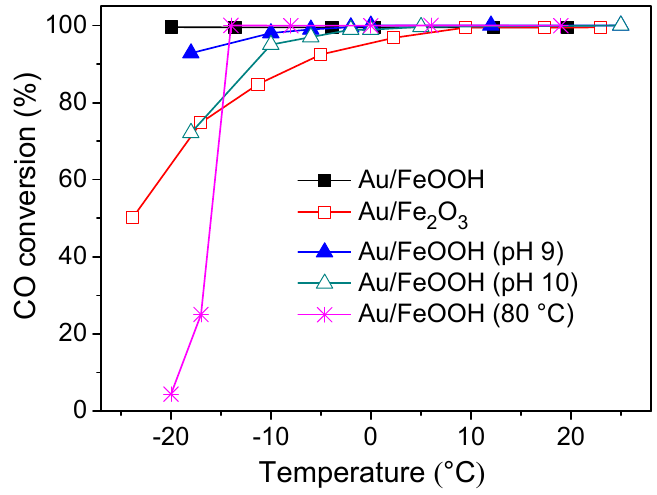
Figure 7. Conversion curves of CO on gold catalysts.